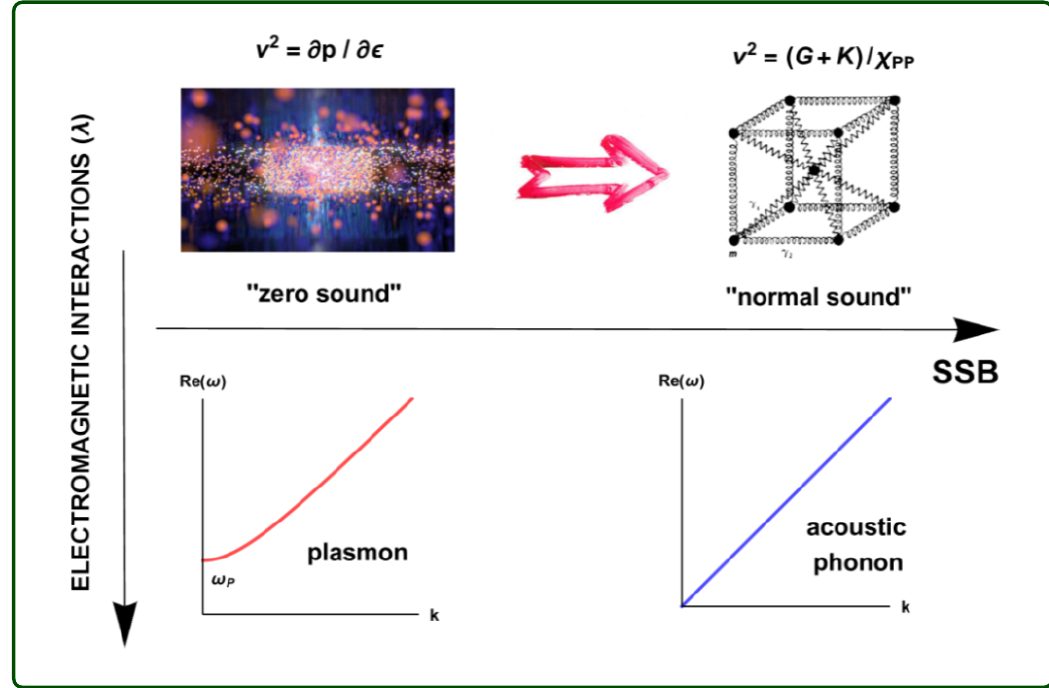
Figure 2 . A simpli(cid:12)ed pictorial representation of the \zero sound" to \normal sound" crossover when increasing the strength of the SSB. The \zero sound", appearing in quantum electron systems like Fermi liquids, gets gapped by the electromagnetic interactions producing the plasmon mode. On the contrary in the \normal sound" regime, typical of an ordered ionic crystal, the electromagnetic interactions do not gap the sound mode. In our system, the unique longitudinal sound mode interpolates between these two regimes by increasing the strength of the